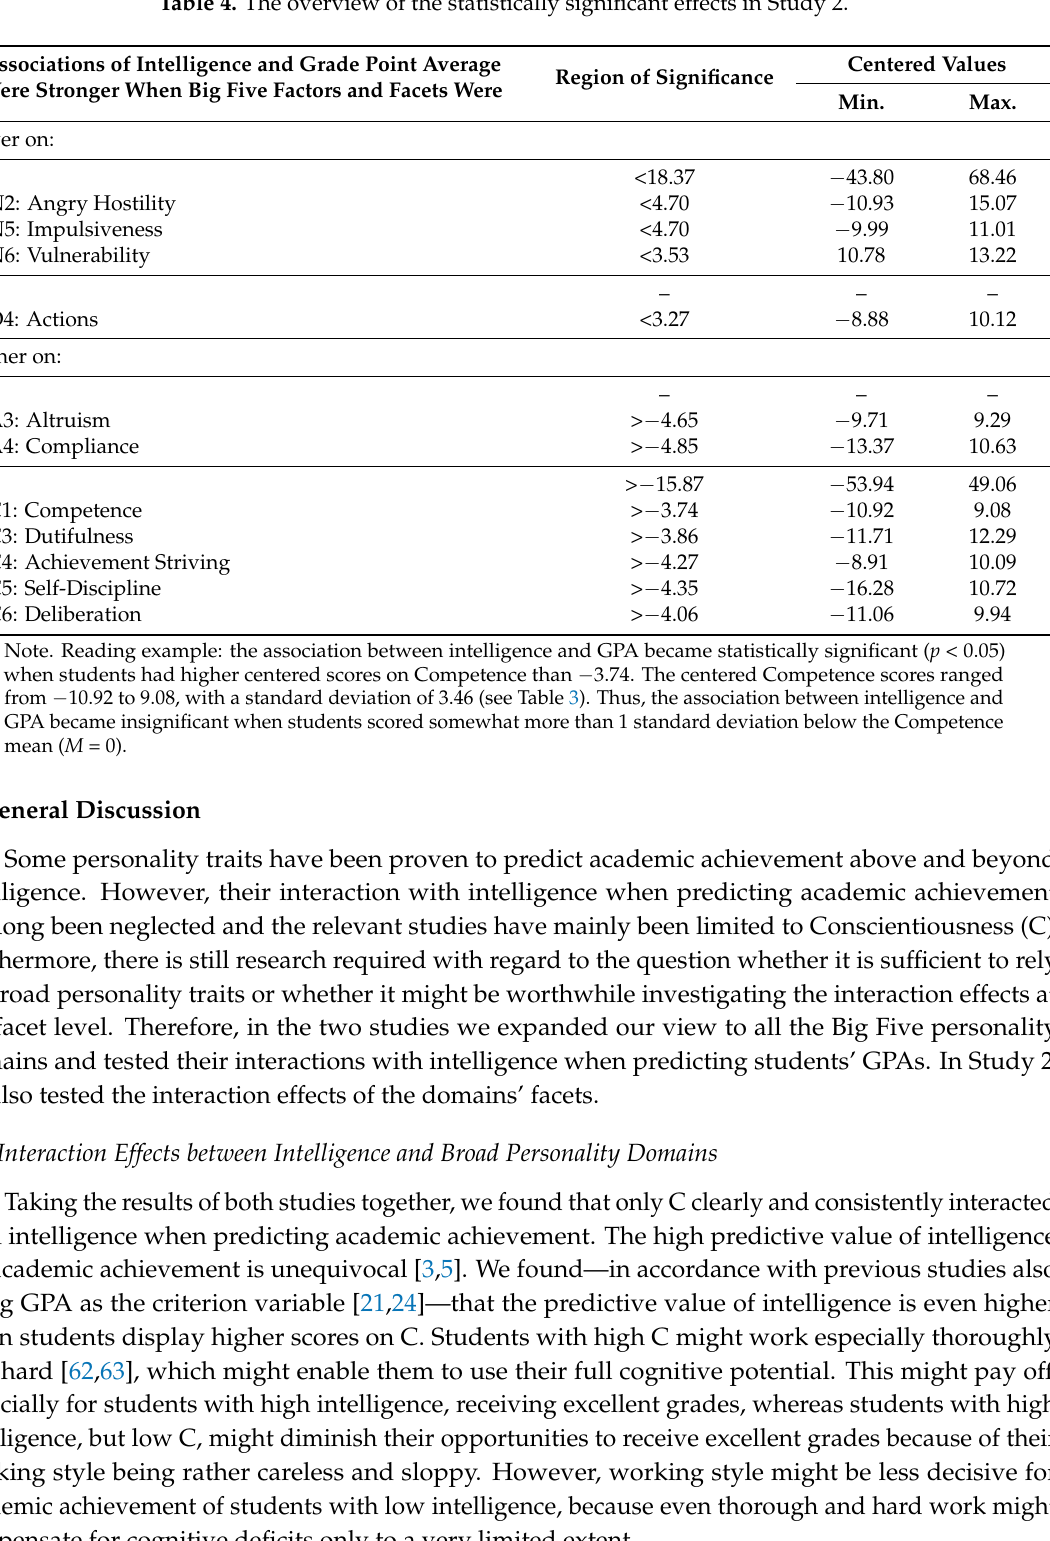
Table 4. The overview of the statistically significant effects in Study